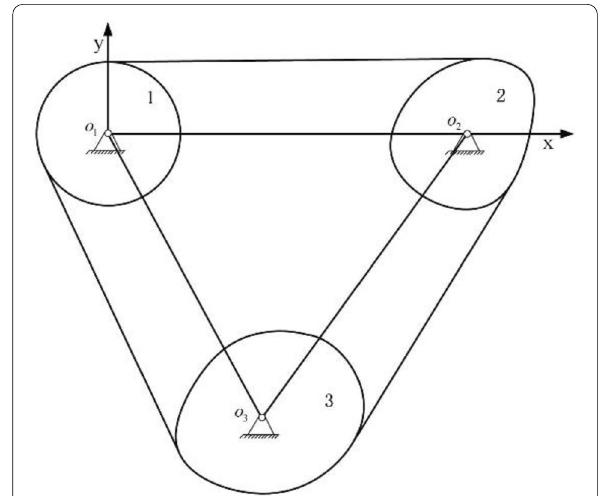
Figure 1 Schematic of three-pulley noncircular synchronous belt transmission